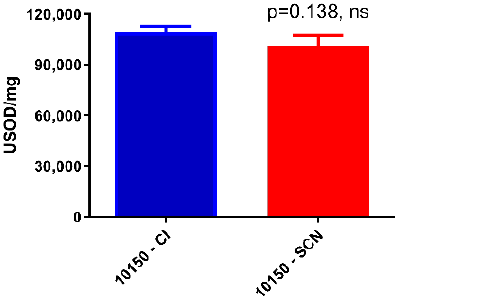
Figure 2. Comparison of the superoxide dismutase (SOD) activity levels of the chloride and thiocyanate formulations of AEOL10150. The SOD activity was determined using a cytochrome c assay spectrophotometrically. A single unit of SOD activity is defined as the ability to inhibit the rate of the reaction of superoxide with cytochrome c by one half; ns: non significant.